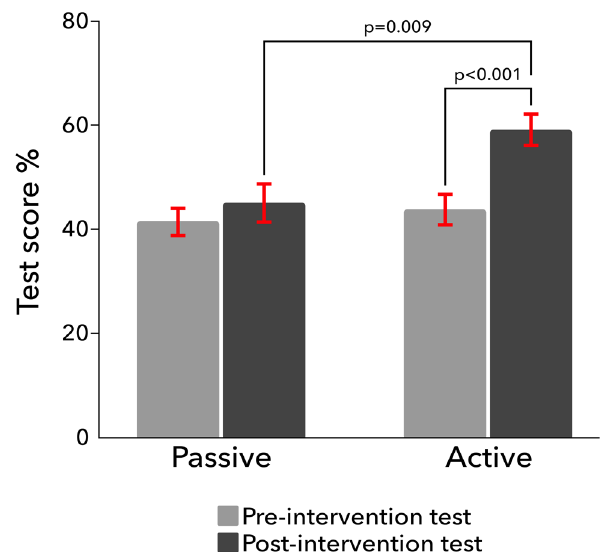
Figure. Pre- and post-intervention test scores for passive and active learning